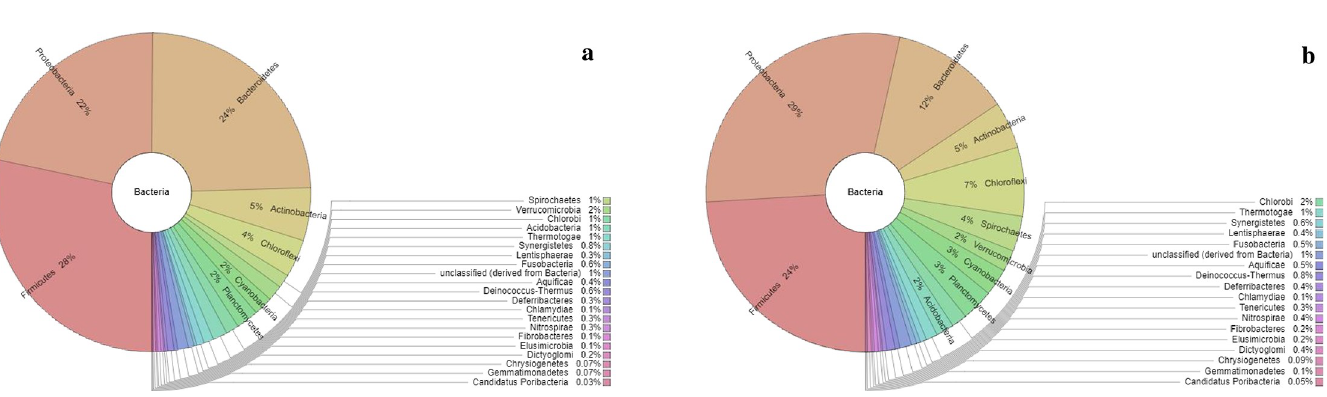
Fig 3. The Krona radial space filling display showing the source evidences of the stated relative abundance of the identified communities in the text (e.g Table 3 and within the text). The display reveals the abundances of the Bacterial reads for the communities identified in reactor 12 and 3: a) Reveals community abundances of reactor 12 while b) reveals community abundances of reactor 3, where Firmicutes and Proteobacteria